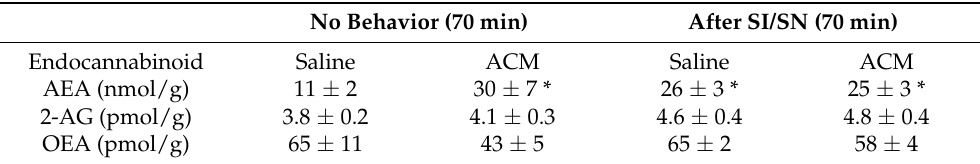
Table 1. Endogenous cannabinoid levels in the BTBR T+tf/J (BTBR) mouse frontal cortex. Reprinted from [24], with permission from Elsevier (license #5034221282113). No Behavior (70 min) After SI/SN (70 min)